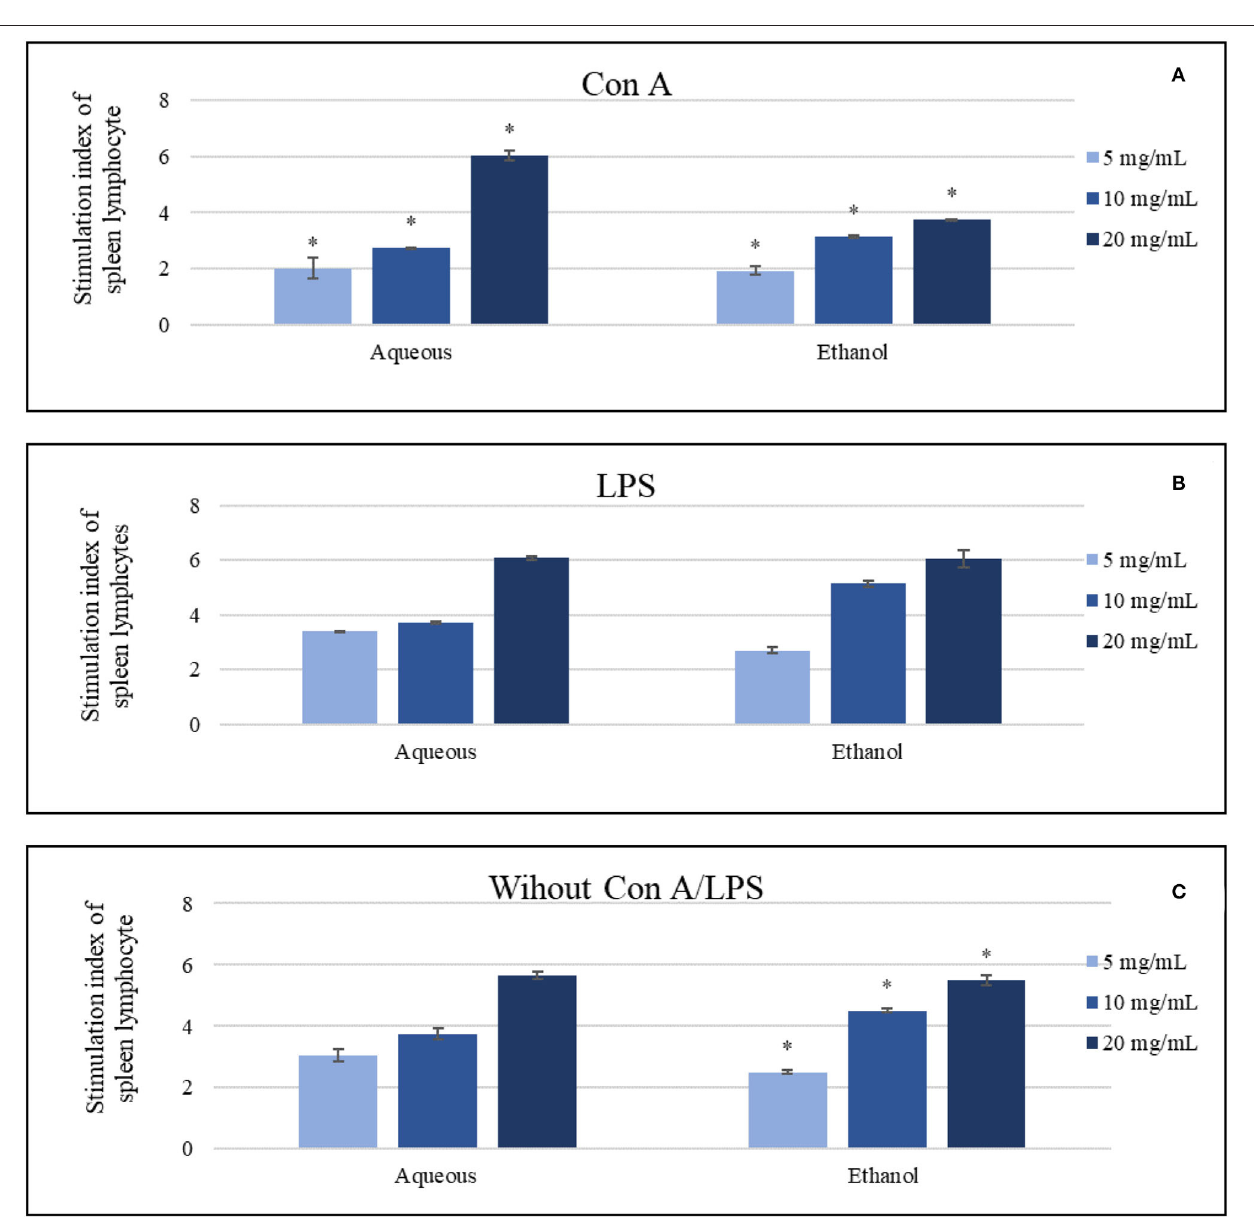
FIGURE 4 | The impact of the aqueous and ethanol extracts (5-20 mg/ml) on the splenic lymphocytes in comparing to negative control, which was 1, (A) in the presence of concanavalin A, (B) in the presence of lipopolysaccharide, (C) in the absence of both Con A and LPS. Results were represented as mean (bars) ± SEM (lines), * P < 0.05 (statistically